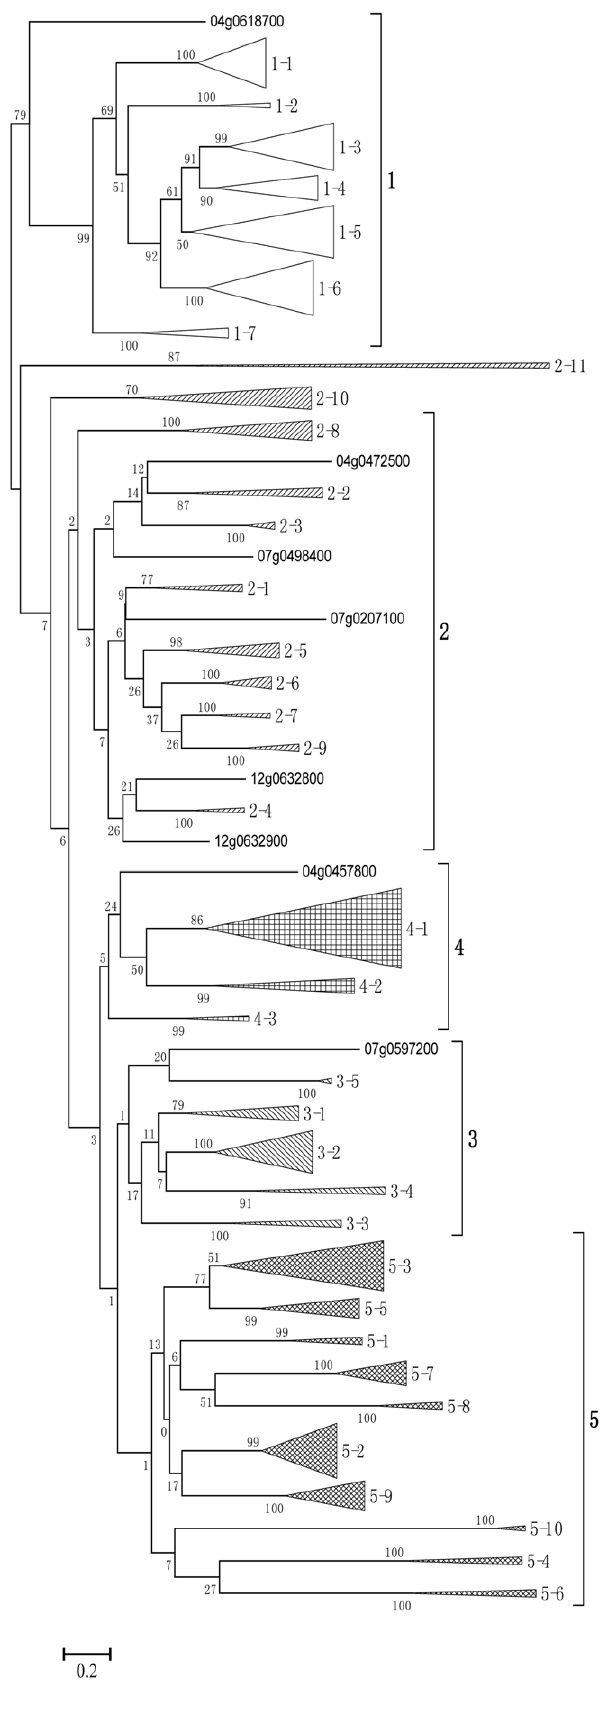
Figure 3. Phylogenetic trees of protein kinases of rice LKs. A ML tree with the Jones-Taylor-Thornton amino acid change model was generated with the protein kinase domain aligned with DIALIGN2. The distance scale is under the figure, and branch lengths are proportional to genetic distance. The LKs were classified into 5 groups, and group and subgroup names are shown on the right. The accession numbers of the LKs in the same subgroup that cannot be shown are replaced by the name of the subgroup.